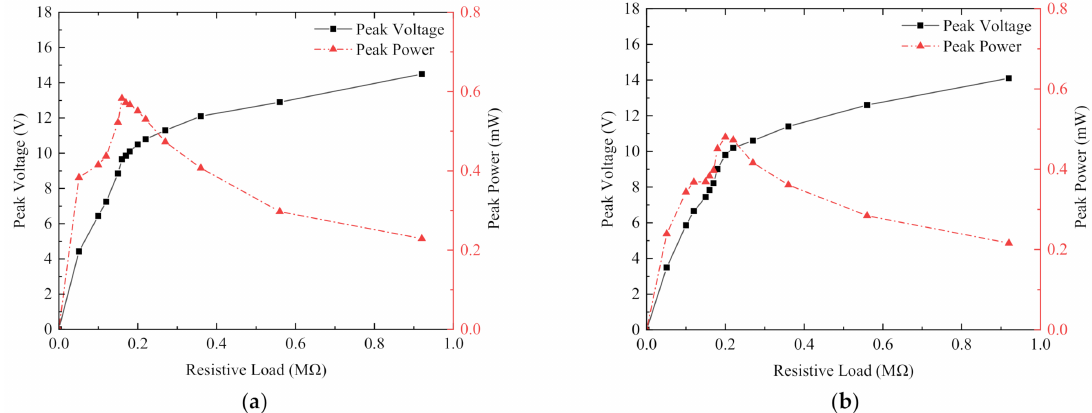
Figure 15. Magnetically coupled piezoelectric–electromagnetic energy harvester piezoelectric output voltage and power: ( a ) load voltage and output power obtained in the x-x piezoelectric sheet rectifier circuit; ( b ) load voltage and output power obtained in the y-y piezoelectric sheet rectifier